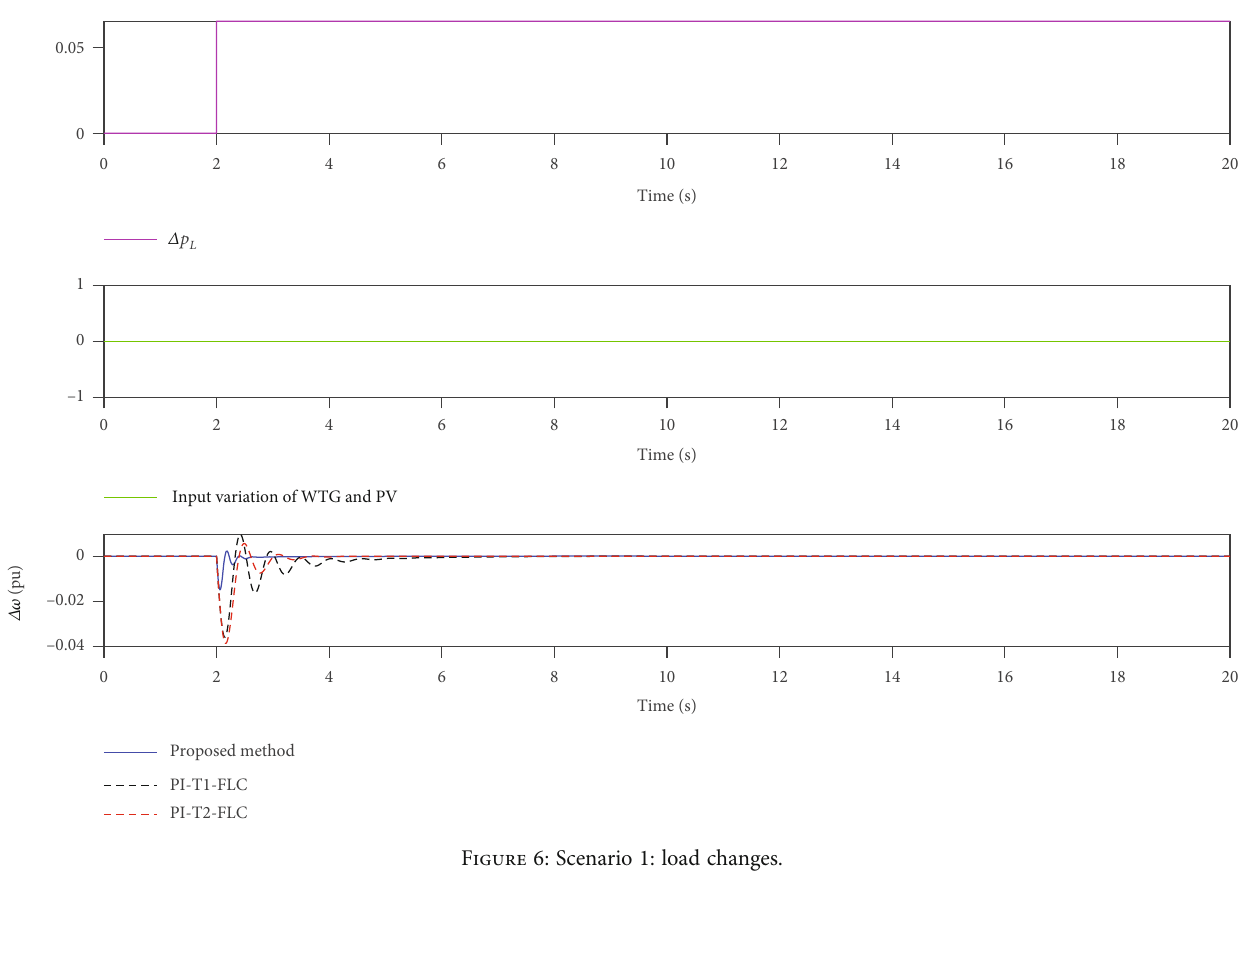
Figure 6: Scenario 1: load